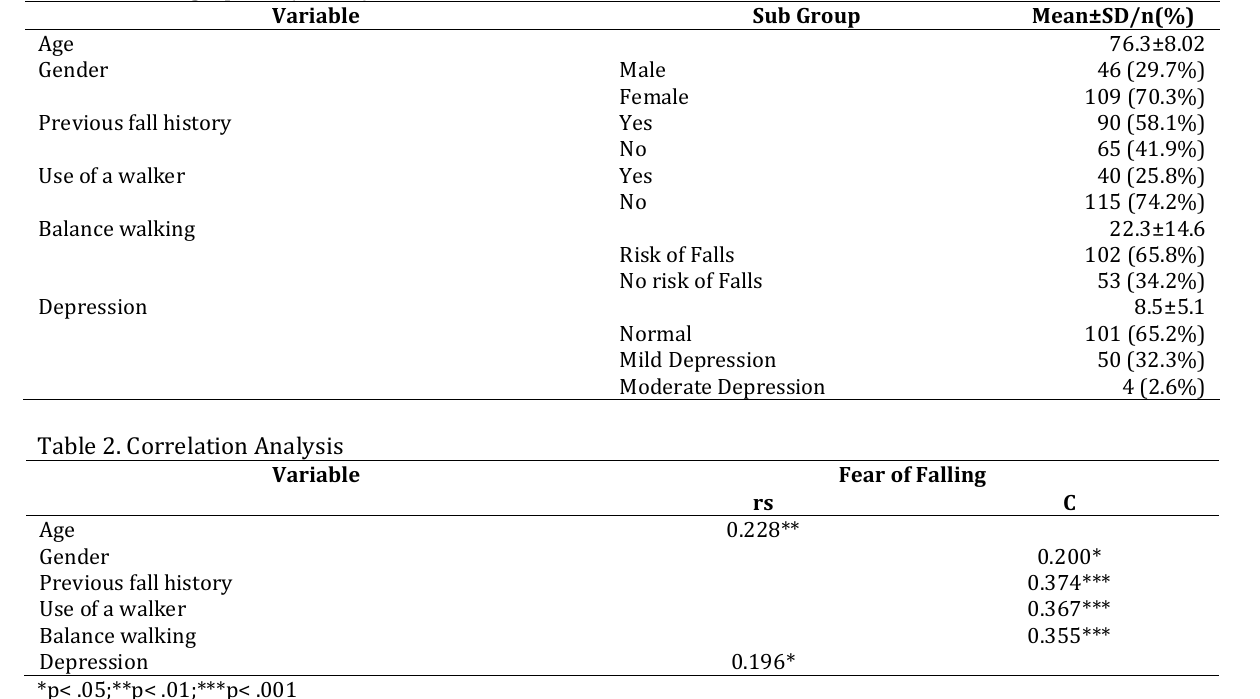
Table 1. Demographics (n: 155)